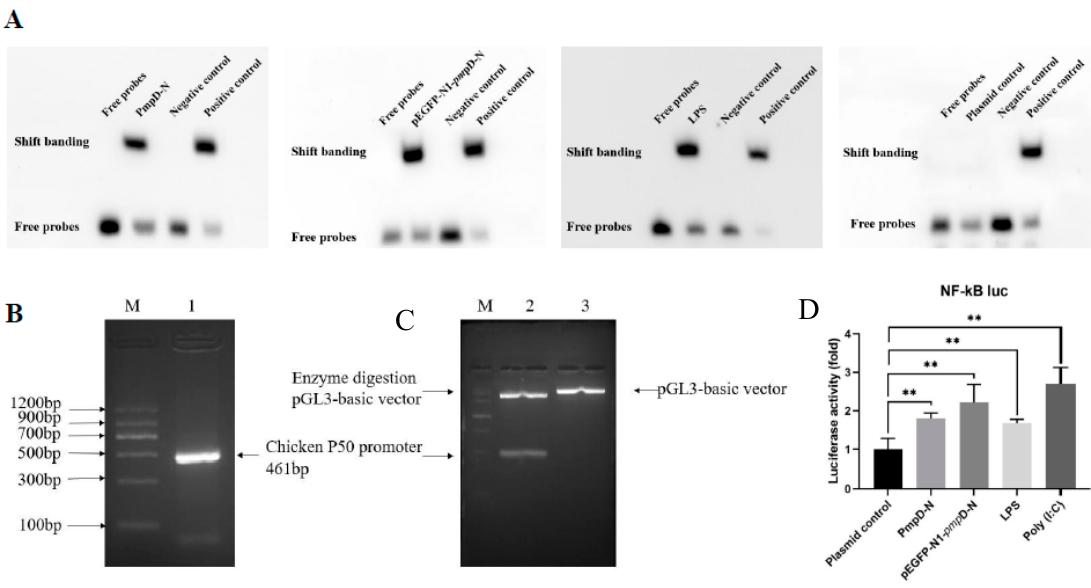
Figure 6. Binding and activation of transcription factor NF- κ B with promoter. ( A ) NF- κ B protein– oligonucleotide complexing was performed using a LightShift chemiluminescent electrophoretic mobility shift assay (EMSA). The transcription factor of NF- κ B was bound to the promoter and showed band shifting post-treatment with rPmpD-N, pEGFP-N1-pmpD-N, or plasmid control. ( B ) Construction of chicken NF- κ B transcription factor P50 promoters was identified to be positive by